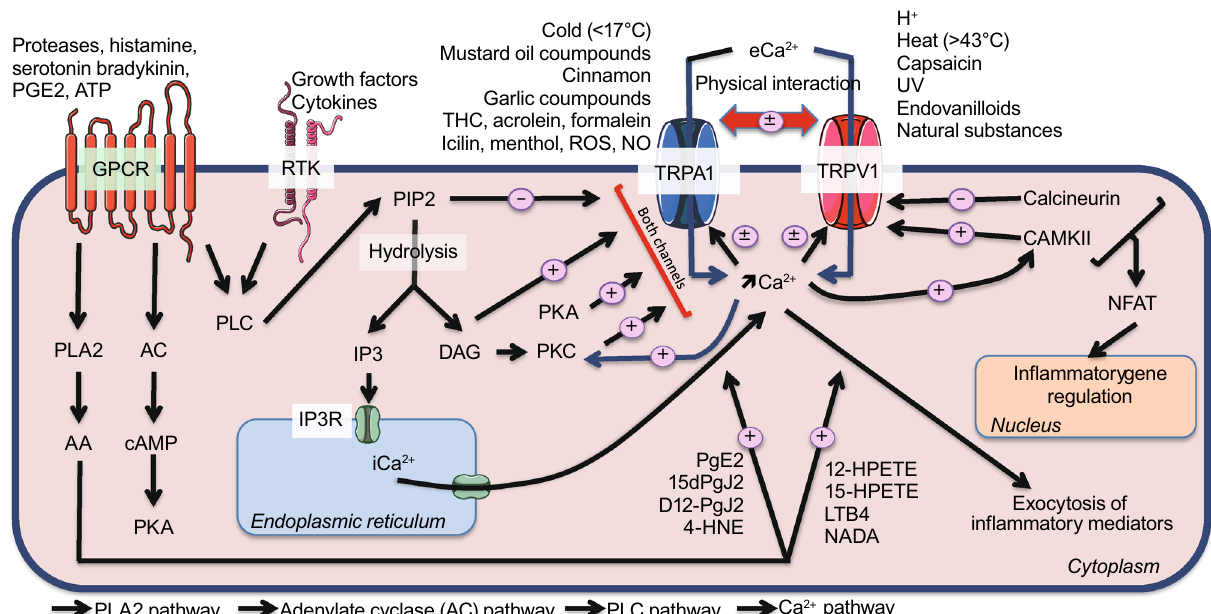
Figure 1. Common intracellular GPCR, RTK and Ca 2+ pathways regulate via the activation and sensitization of TRPV1 and TRPA1. The G protein-coupled receptor (GPCR) and receptor tyrosine kinase (RTK) activation stimulate phospholipase C (PLC), which leads to phosphatidylinositol 4,5-bisphosphate (PIP2) hydrolysis and the consequent release of the transient receptor potential (TRP) channels from its inhibitory control, triggering the formation of 1,4,5-trisphosphate (IP3) and diaglycerol (DAG) as well as the in fl ux of Ca 2+ via TRP vanilloid 1 and ankyrin 1 (TRPV1 and TRPA1). Then, DAG can directly activate both TRP channels, and protein kinase C (PKC) activation by DAG enhances TRP activity, sensitizing both channels. IP3 formation promotes Ca 2+ release from the endoplasmic reticulum and increases the iCa 2+ concentration. GPCRs can also activate the phospholipase A2 (PLA2) and adenylate cyclase pathways, which lead to protein kinase A (PKA) stimulation and the formation of arachidonic acid (AA) metabolites and products. PKA acts directly sensitize the TRP channels, while AA metabolites and products directly activate the TRP channels. Both TRPV1 and TRPV1 can directly or indirectly regulate the activity of the other by direct interaction or via the iCa 2+ concentration, resulting in a cross-sensitization/desensitization process. The elevation of iCa 2+ triggers the exocytosis of in fl ammatory mediators and stimulates both Ca 2+ /calmodulin-dependent kinase II (CAMKII) and calcineurin, which sensitize and desensitize TRPV1, respectively. Both kinases are also involved in the regulation of in fl ammatory genes via nuclear factor of activated T-cell (NFAT) translocation to the